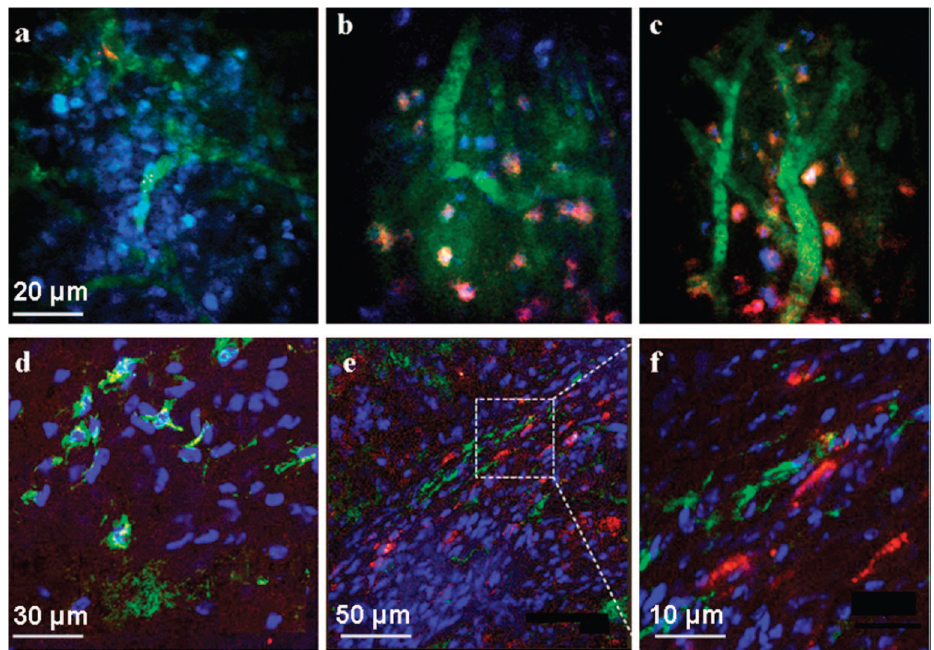
Figure 3. Detection of Nanotube Bioconjugates in Tumors in vivo. Representative frames from time-lapse videos acquired by 3-color, intravital two-photon microscopy ( a – c ). Mice bearing the HN12 xenografts were anesthetized and treated with SQ or SQE (red) bioconjugates. Cell nuclei were stained with Höechst (blue) and blood vessels with 500 kDa FITC-dextran (green): For SQ alone with no EGF ( a ), very little or no red fluorescence representing the Qdot signal was detected within the tumor mass 45 min after injection. Two different views after administration of SQE giving red fluorescence 45 min post injection within the tumor microenvironment ( b , c ). The red SQE bioconjugate is localized in close proximity to the nuclei suggesting its internalization by the tumor cells within the xenograft. (Scale bar in a-c is 20 µm). Confocal microscopy images of fixed xenograft cryosections ( d – f ) In the SQ treated tumor sections ( d ), only Höechst stained cell nuclei (blue) and vascular FITC-labeled dextran (green) are visible (scale bar 30 µm). ( e ) In SQE treated mice, characteristic red fluorescence was widely distribution within the tumor microenvironment. (scale bar 50 µm). ( f ) Magnified dotted region of ( e ) showing internalized SEQ bioconjugates the cells within the tumor mass. (scale bar 10 µm). (Reprinted with permission from [59]. Copyright 2009, Bhired et al.) ( a – f